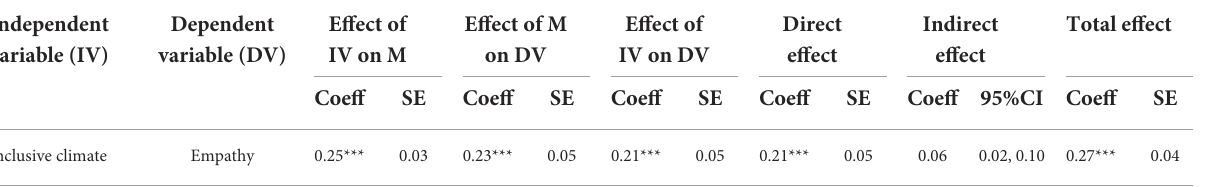
TABLE 5 Mediation analyses (5,000